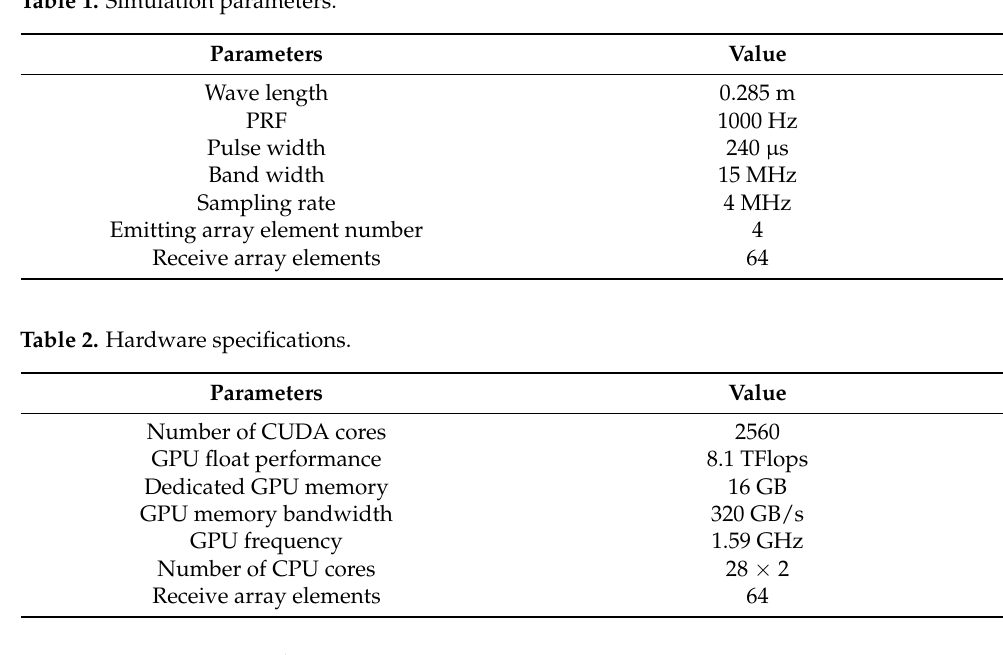
Table 1. Simulation parameters.